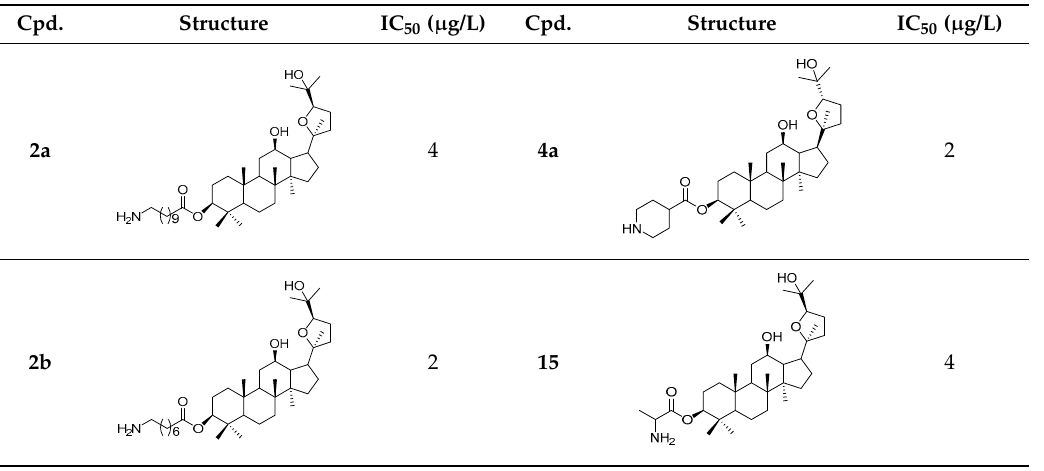
Table A1. Dataset used for Pharmacophore analysis.